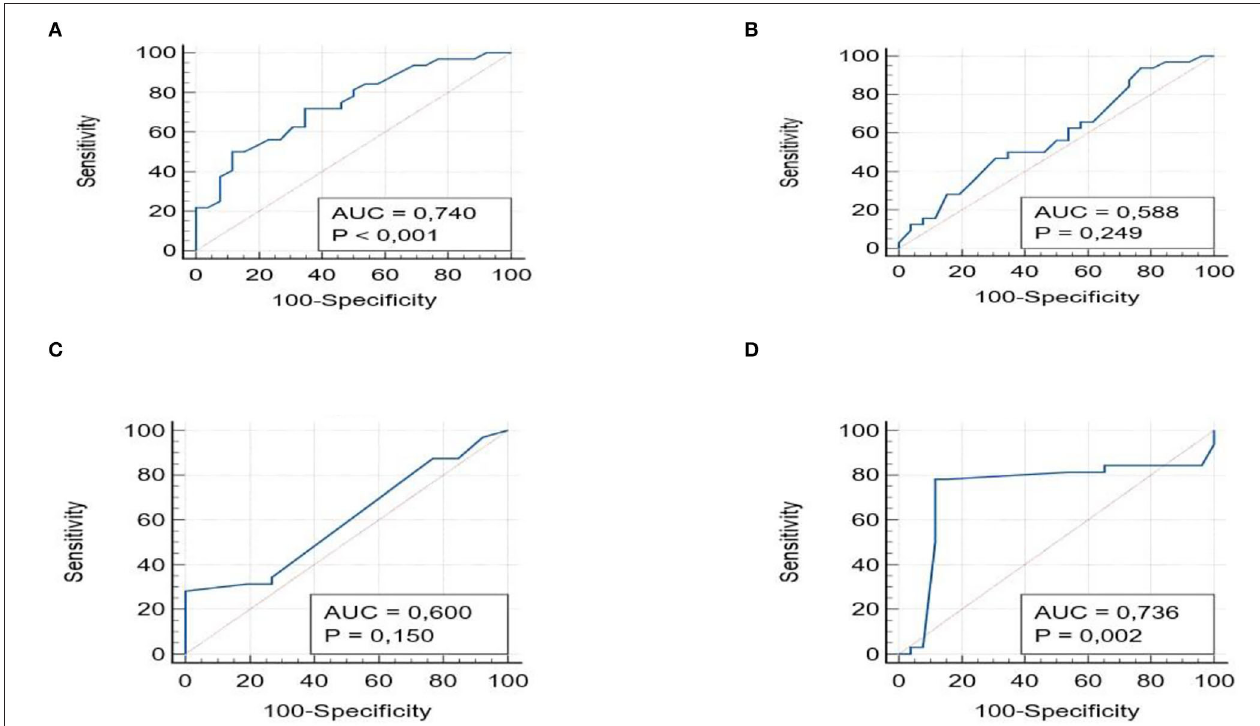
FIGURE 2 | ROC curves with the AUROCs for APRI (A) , FIB-4 (B) , NSF (C) , and Hepamet (D) for Fibrosis